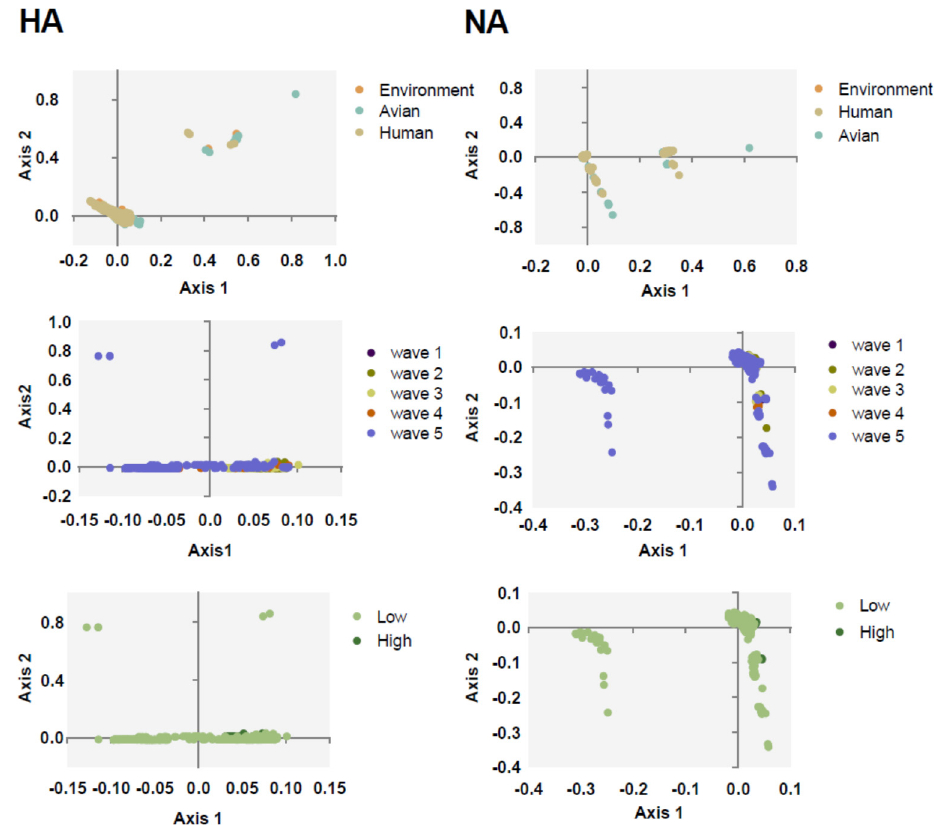
Figure 2. PCA taxonomic analysis of HA ( left column ) and NA ( right column ). The environment, human, and avian are represented in orange, beige, and cyan, respectively. Circles are marked by dark purple, olive green, light yellow, orange, and light purple, corresponding to waves 1 to 5, respectively. Grass green corresponds to high pathogenicity.